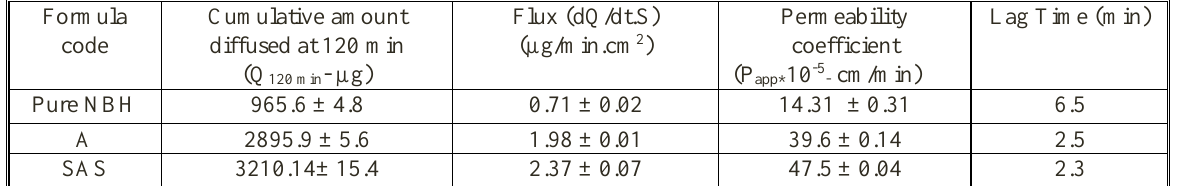
Table 3. The Diffusion Parameters of Permeability study for Nebivolol from Plain Suspension, Conventional and Supersaturable